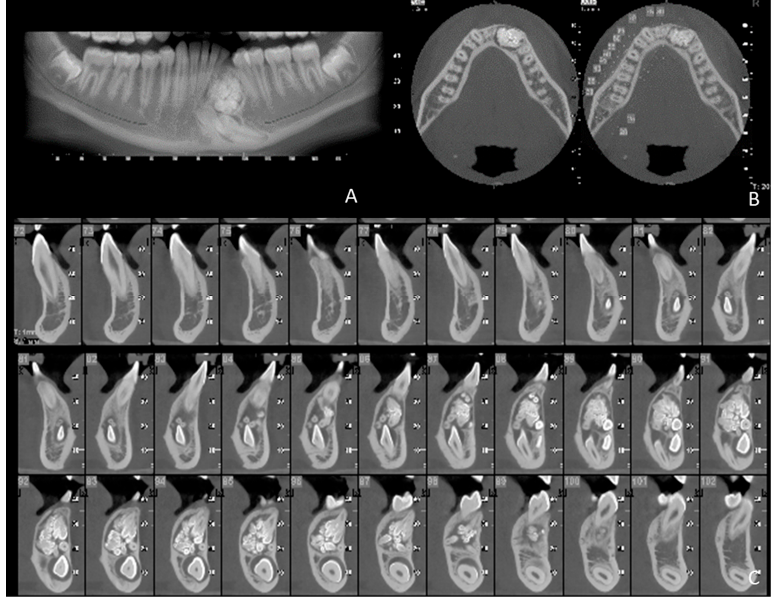
Figure 6. Series of images from cone beam computed tomography (CBCT). ( A ) The localization of the neoformation is anterior to the emergence of the mandibular nerve, which is at the level of element